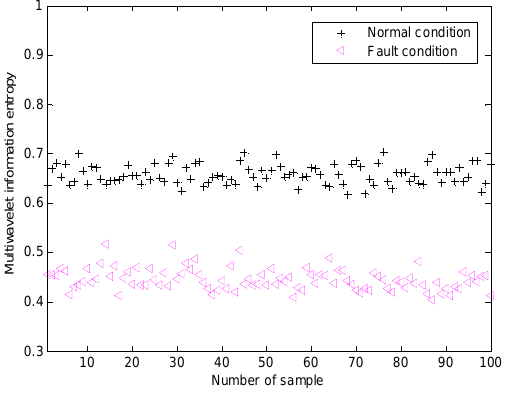
Figure 27. According to Figure 27, we can find that the multiwavelet entropy values of vibration data on normal condition are 0.62–0.71. Meanwhile, the multiwavelet entropy values of vibration data on fault condition are 0.39–0.52. The result shows that the proposed method can accurately identify the fault condition of planetary gearbox based on noisy condition vibration data.